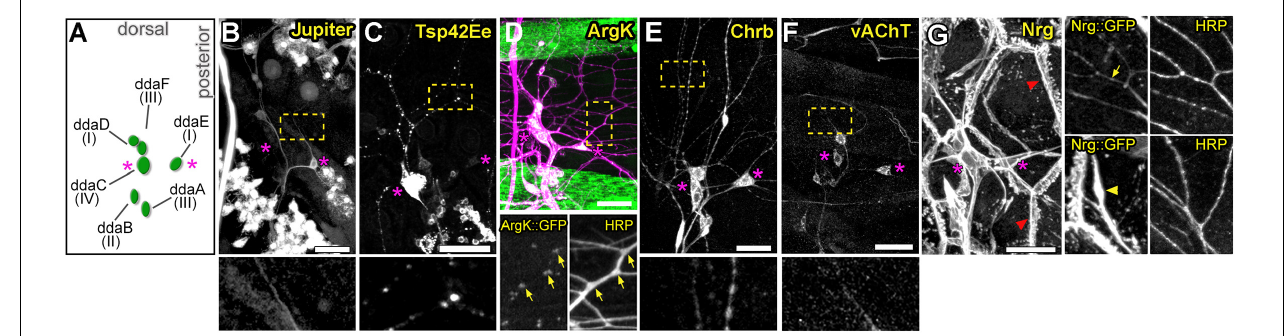
FIGURE 2 | Expression patterns of select protein trap lines in dorsal cluster sensory neurons. (A) Schematic of typical cell body positions of da neurons in the dorsal cluster of the larval body wall. Labels show names and neuron class. Magenta asterisks in all panels mark positions of ddaE (right) and ddaC (left) for spatial reference. Examples of class-specific expression in Jupiter::GFP (B) and Tsp42Ee::GFP (C) lines, punctate dendritic GFP pattern in ArgK::GFP (D) , widespread sensory expression in Chrb::GFP (E) and vAChT::GFP (F) lines. Bottom panels show enlarged regions marked by yellow rectangles in panels above. Note